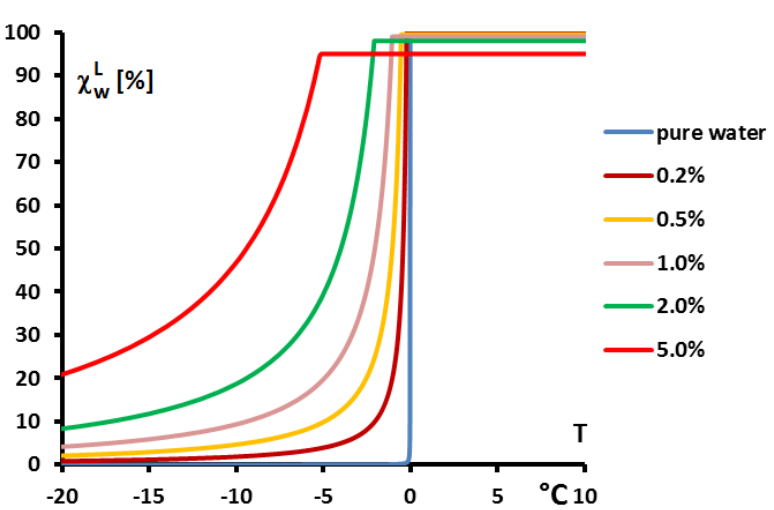
Figure 19. Mass fraction of liquid χ L w (percentage) versus T at different y 0 (percentage).